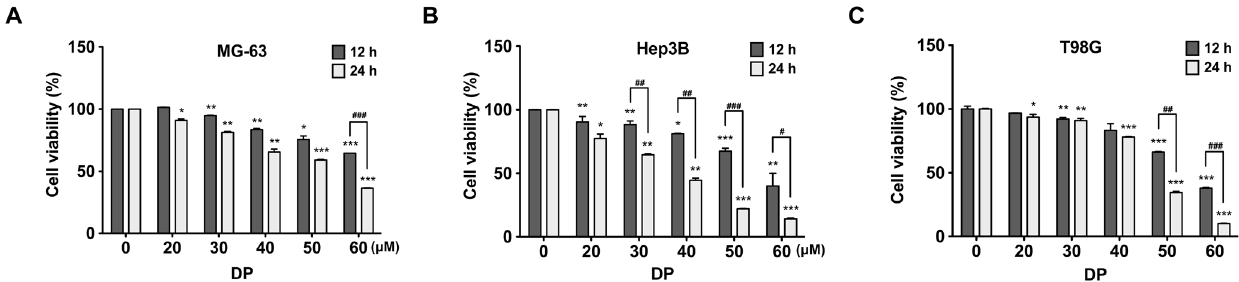
Figure 1. Effects of DP on cell viability in human cancer cells. (A) MG-63, (B) Hep3B and (C) T98G cells were treated with various concentrations of dendropanoxide (DP) for 12 and 24 h and then cell viability were measured by MTT assay. Data were presented as percentage of control and were mean 6 SEM (n=3 2 4). * P , 0.05, ** P , 0.01 and *** P , 0.001 compare with control; # P , 0.05 ## P , 0.01 and ### P , 0.001 compared with